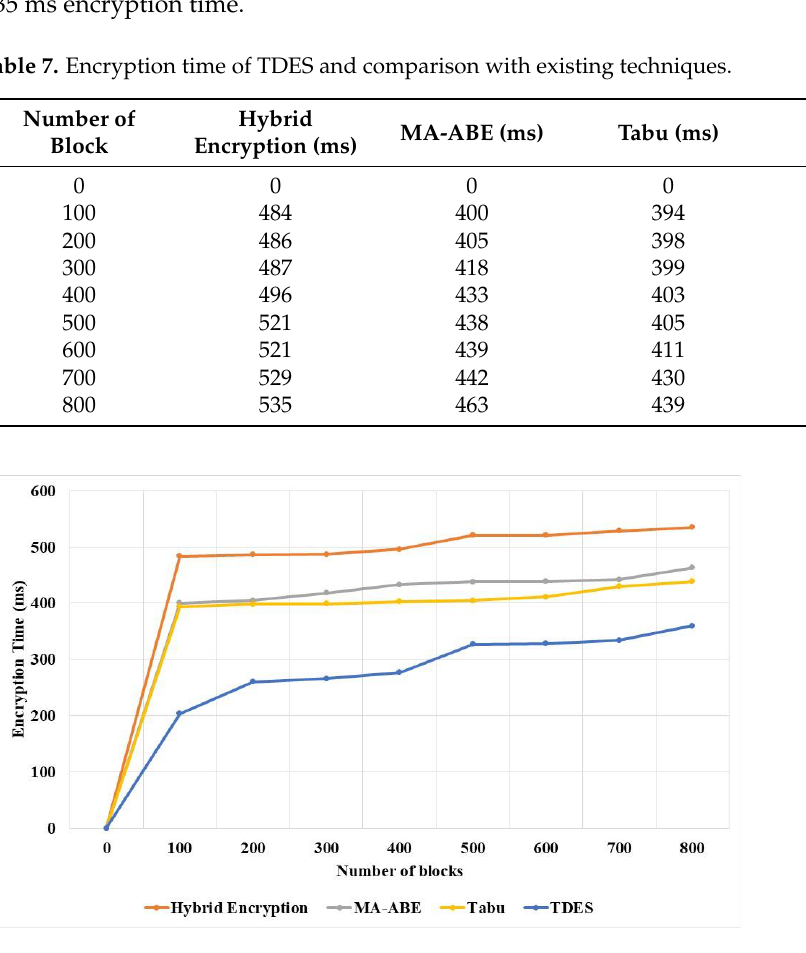
Table 8. Decryption time of TDES and comparison with existing methodologies. Number of Block Hybrid Encryption (ms) MA-ABE (ms) Tabu (ms)